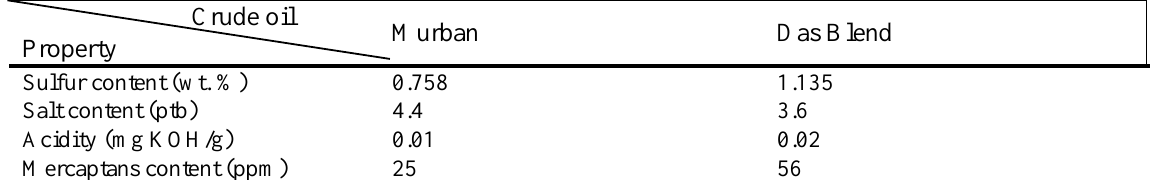
Table 2. Corrosive aided properties of both crude